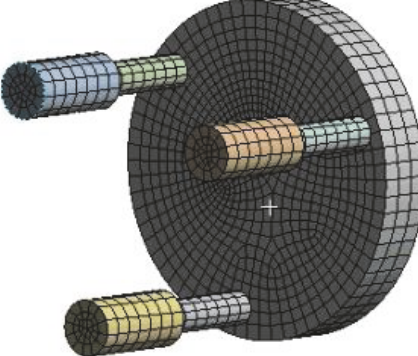
Figure 5: Finite element model of pin-on-plate friction